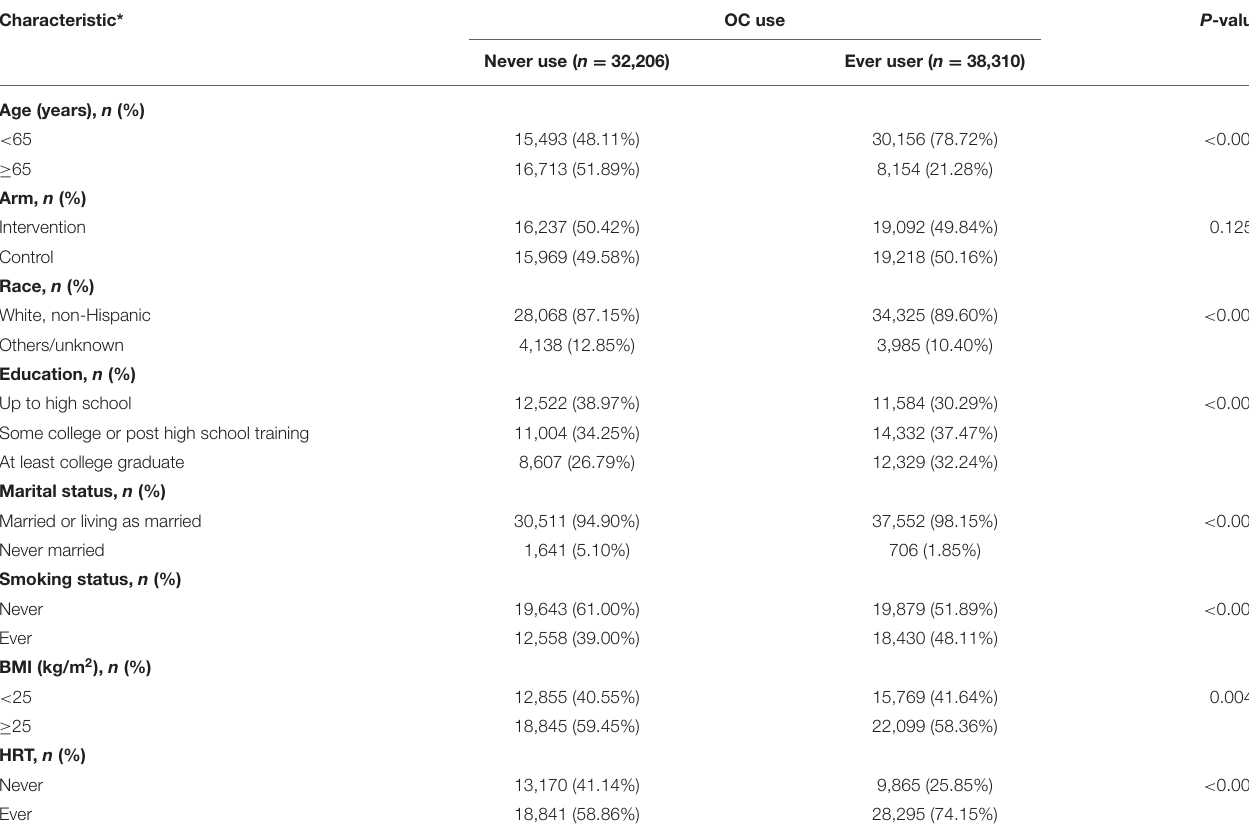
TABLE 1 | Baseline participant characteristics according to OC use in the PLCO trail. Characteristic*